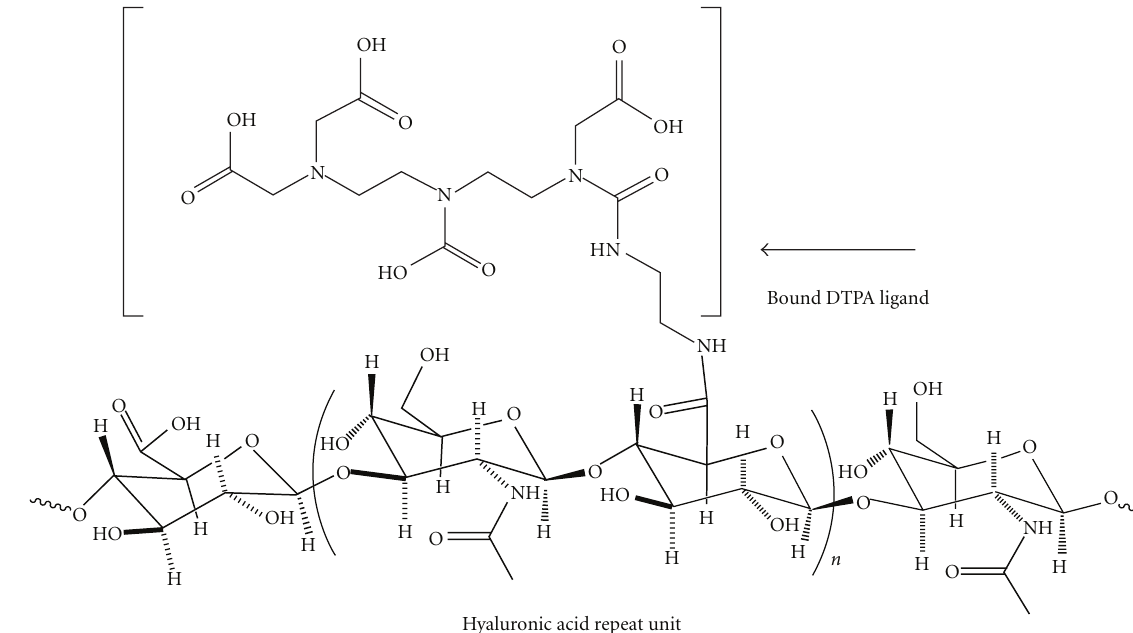
Figure 2: Hyaluronic acid repeat unit with amide bound diethylenediamine pentacetic acid. The Gd 3+ ion is complexed with the bound DTPA ligand to yield the imaging agent, which is then coupled to HA via standard carbodiimide coupling methods.